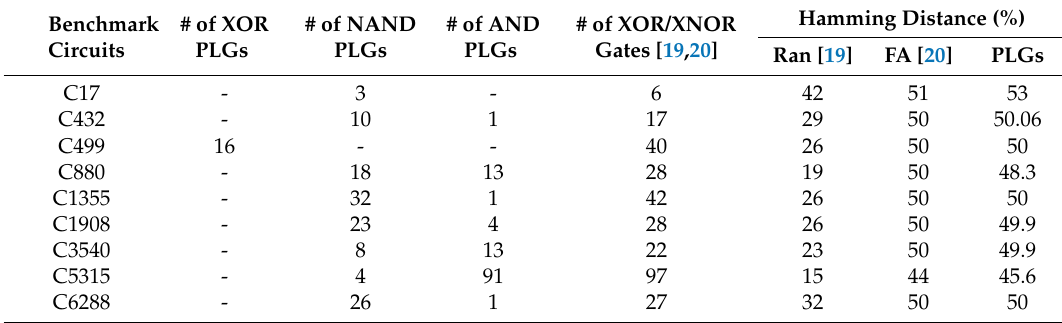
Table 2. The number of polymorphic logic gates to achieve 50% Hamming distance using our proposed scheme compared to previous